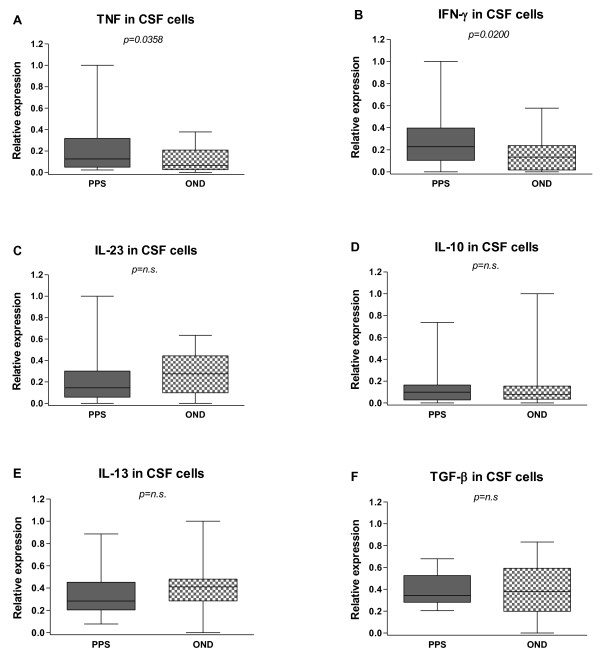
Baseline levels of inflammatory cytokines in the cerebrospinal fluid (CSF) cells. Cytokines were measured in patients with Post-polio syndrome (PPS) and with other neurological diseases (OND). The median-based box plots indicate 25th/75th percentiles and whiskers indicate 5th/95th percentiles. Values of statistical significance are indicted (n.s.: non significant).